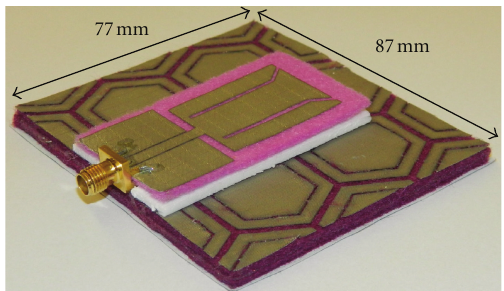
Figure 16: CPW-fed antenna on AMC prototype using felt and electrotextile.